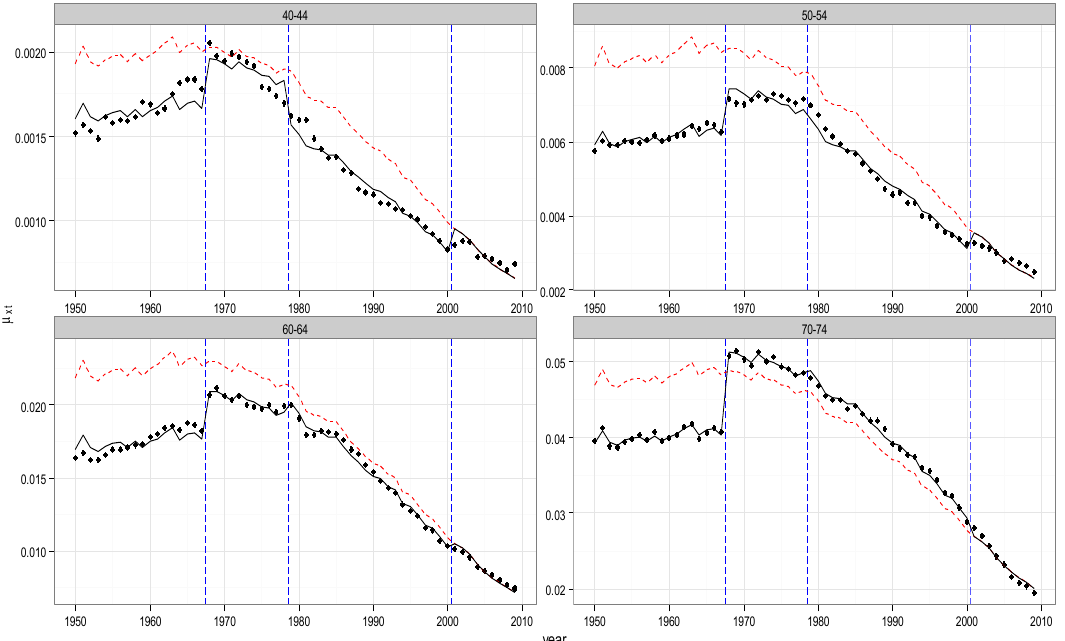
Figure 3. Adjusted mortality index, Cancer and Circulatory System Illness, UK Male population, age groups 40–45, 50–54, 60–64, 70–74.